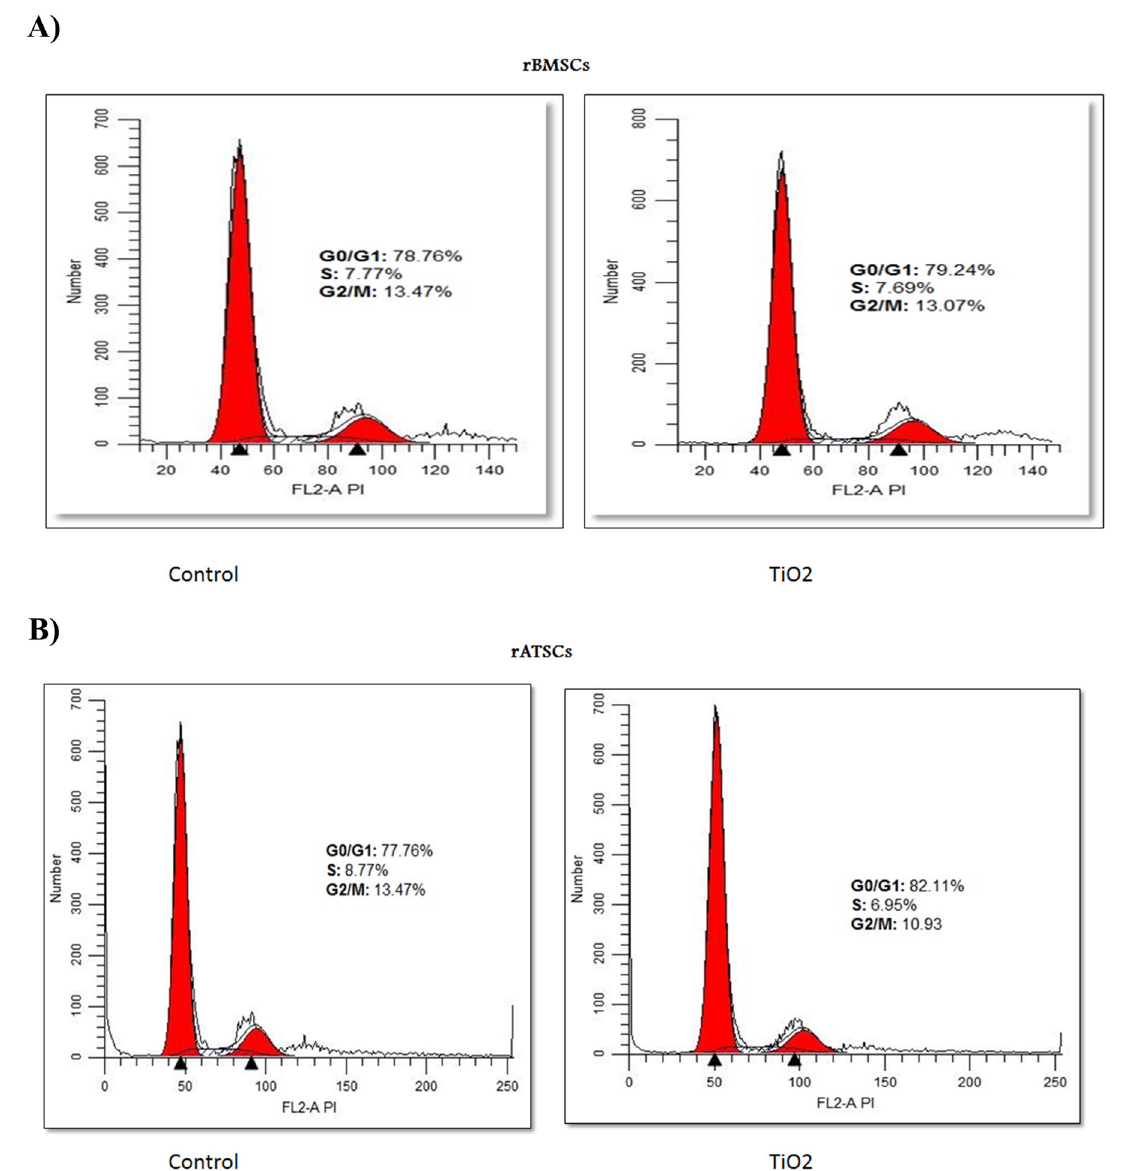
Fig. 5 Inhibitory effect of TiO 2 NPs on cell cycle progression of both rBMSCs and rATSCs after treating for 72 h in concentration around their IC 50 (200 μ g/ml). A The rBMSCs exposed to 100 µg/ml TiO 2